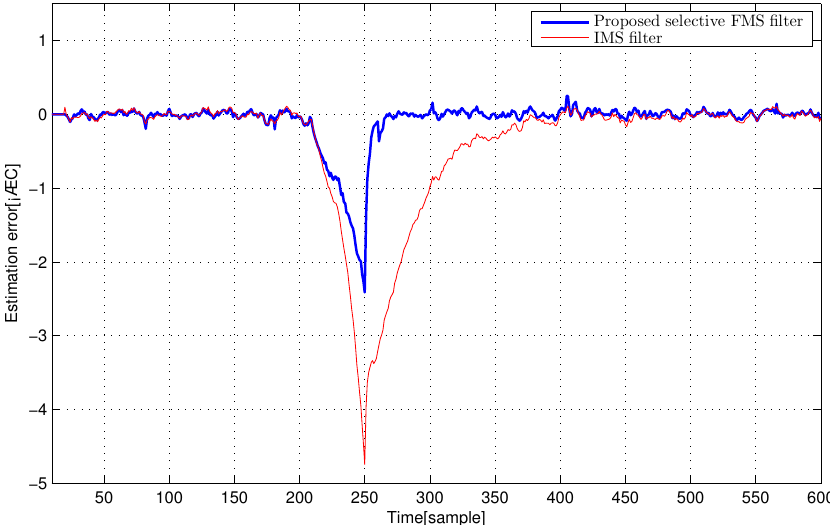
Figure 8. Estimation errors of the proposed selective FMS and IMS filters for the F404 gas turbine aircraft engine